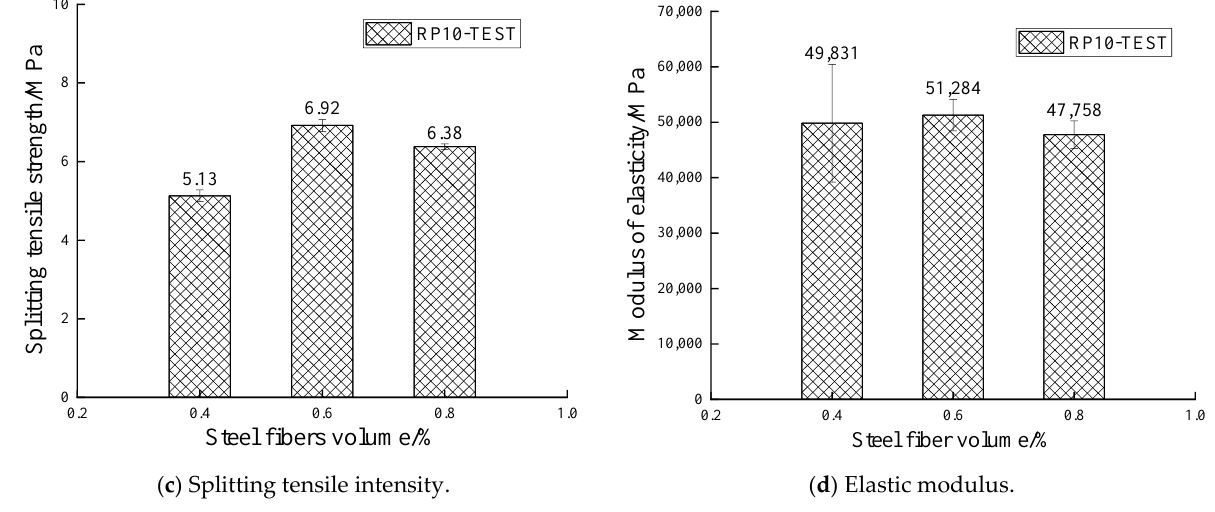
Figure 5. Mechanical characteristics of concrete with 10% LP incorporating different steel fiber GSF0325 contents.